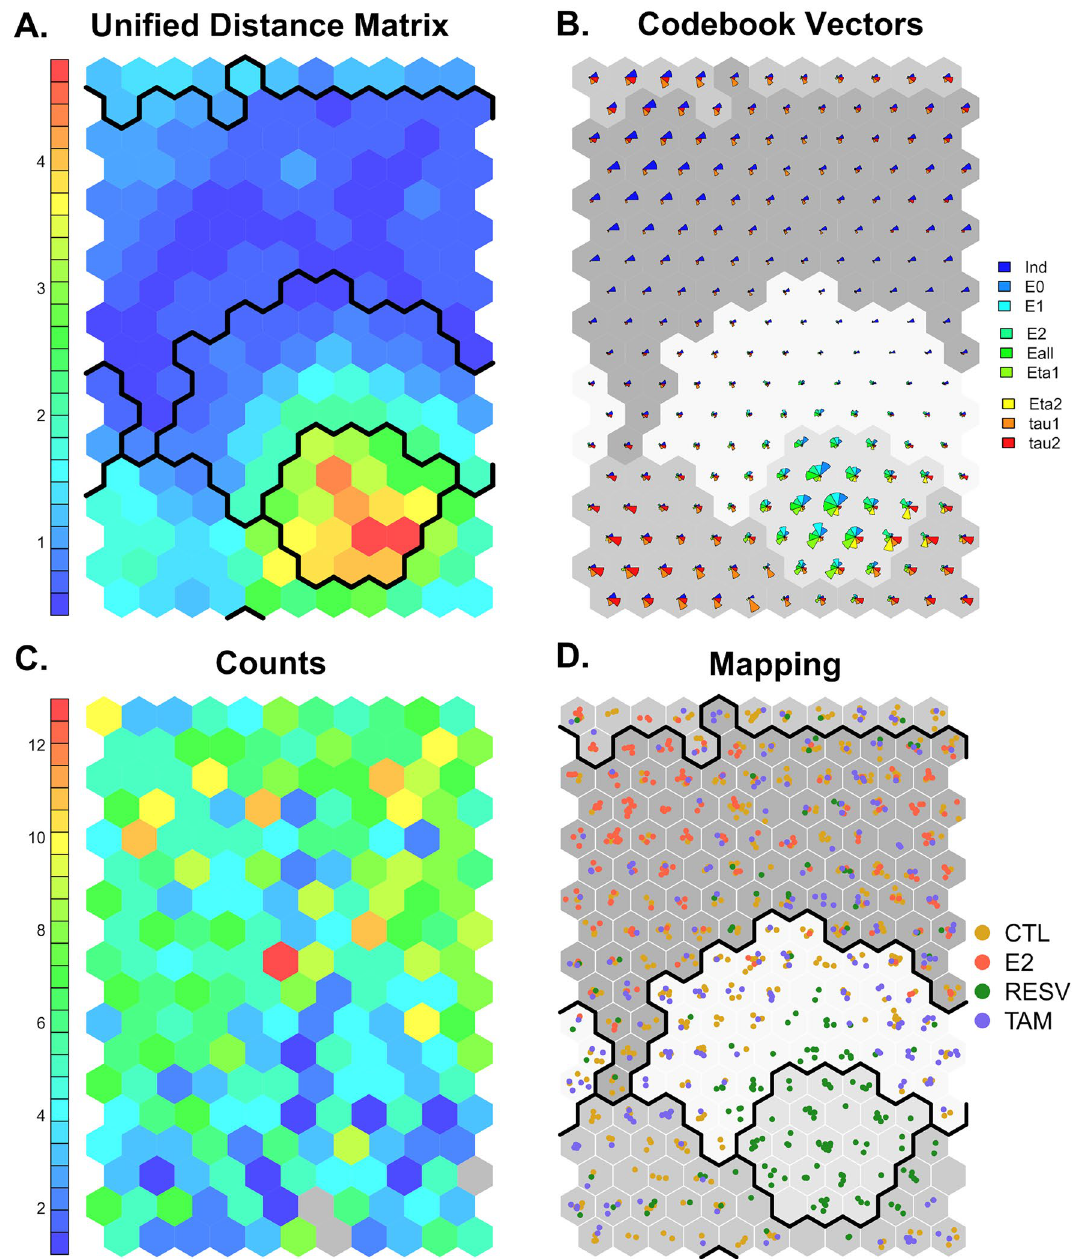
Figure 1. Results of training the self-organizing map using a batch algorithm. ( A ) Unified distance matrix plot. The colour scale corresponds to Euclidean distance between nodes. The post hoc clustering was performed using kmeans clustering with 4 centroids. ( B ) Fan-diagram showing the spatial distribution of the nine different variables on the 2D map. δ is indentation, E ∞ the equilibrium modulus, E 1 and E 2 the moduli of the springs in Maxwell arms, E inst the instantaneous modulus, τ 1 and τ 2 the relaxation times of the dashpots and the viscosities are η 1 and η 2 . ( C ) Counts plot of the number of observations per node. In grey nodes, zero observations are placed. ( D ) Mapping of the treatment as input factors. Cluster 1 includes 227 measurements, Cluster 2 69, Cluster 3 195 and Cluster 4 In Fig. 1A the unified distance matrix of the SOM can be seen. The colour scale indicates the Euclidean dis- tance between nodes, blue tones indicate small distances, while red tones indicate large ones. A distinct region with high dissimilarity can be observed at the bottom right of the map (visible as cluster). Note that the map is toroidal, thus reducing edge effects. The dark black lines indicate the post hoc clustering of the nodes. Figure 1B shows the distributions of the single codebook vectors and the determined clusters in greyscales. This analysis can be used to analyse the distribution of the single input variables. Even for the low number of input variables, this analysis can be quite overwhelming, as only regions with significant differences can be seen easily. As an